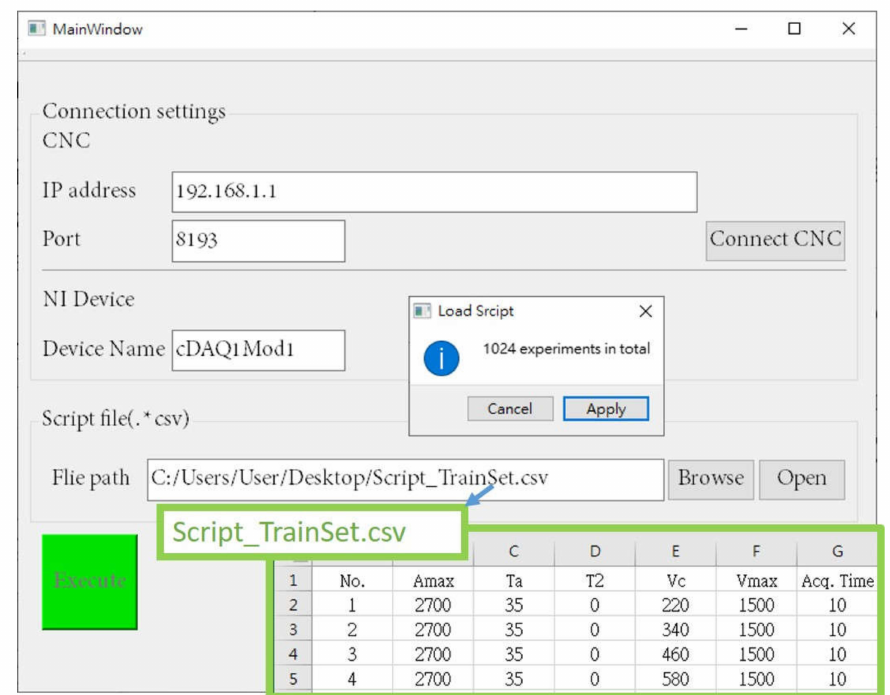
Figure 4. Human–machine interface (HMI) of the automated acquisition system. The experiments were conducted on a three-axis horizontal milling machine (Tongtai HA-500II was manufactured by Tongtai Machine and Tool Co., LTD., R.O.C., Kaohsiung City, Taiwan), with the three-axis accelerometer (PCB 356A32) installed on the spindle housing, as shown in Figure 5.